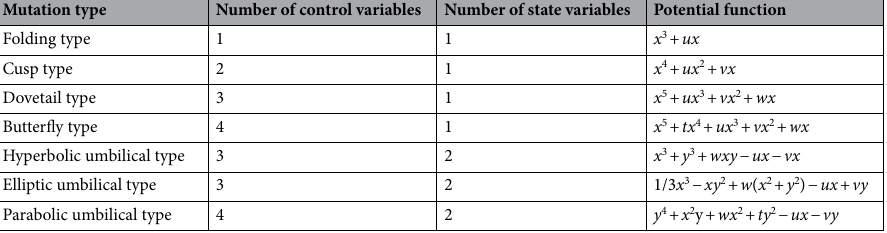
Table 4. Several common mutation models.